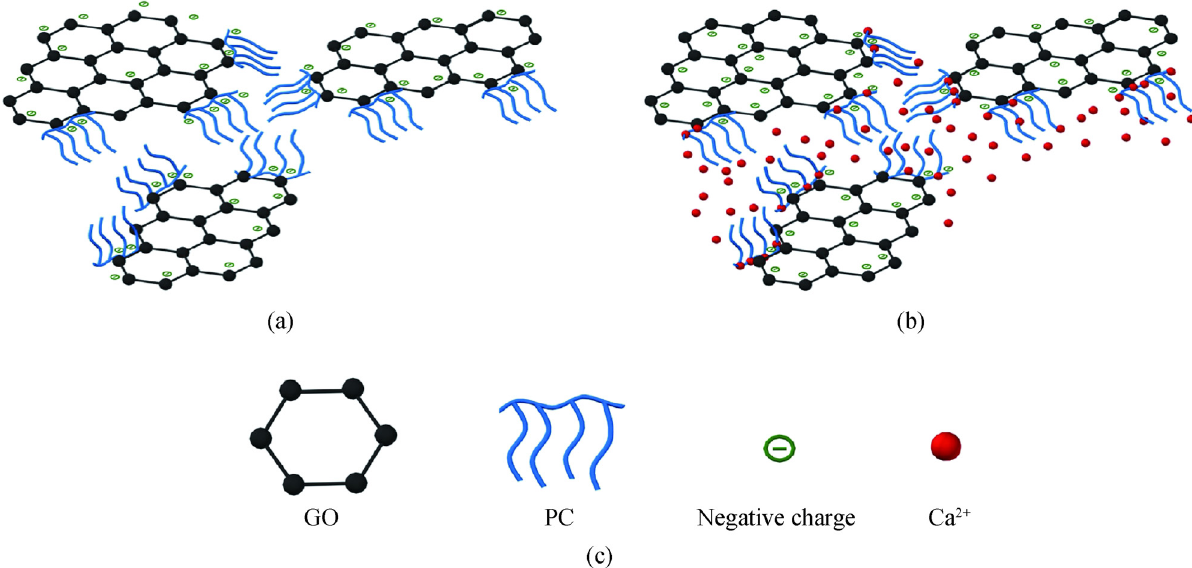
Figure 4: Dispersion mechanism of PC – GO [ 48 ] : ( a ) dispersion mechanism in water, ( b ) dispersion mechanism in cement paste, and ( c ) simulated structures of the GO, PC, negative charge, and Ca 2 + .